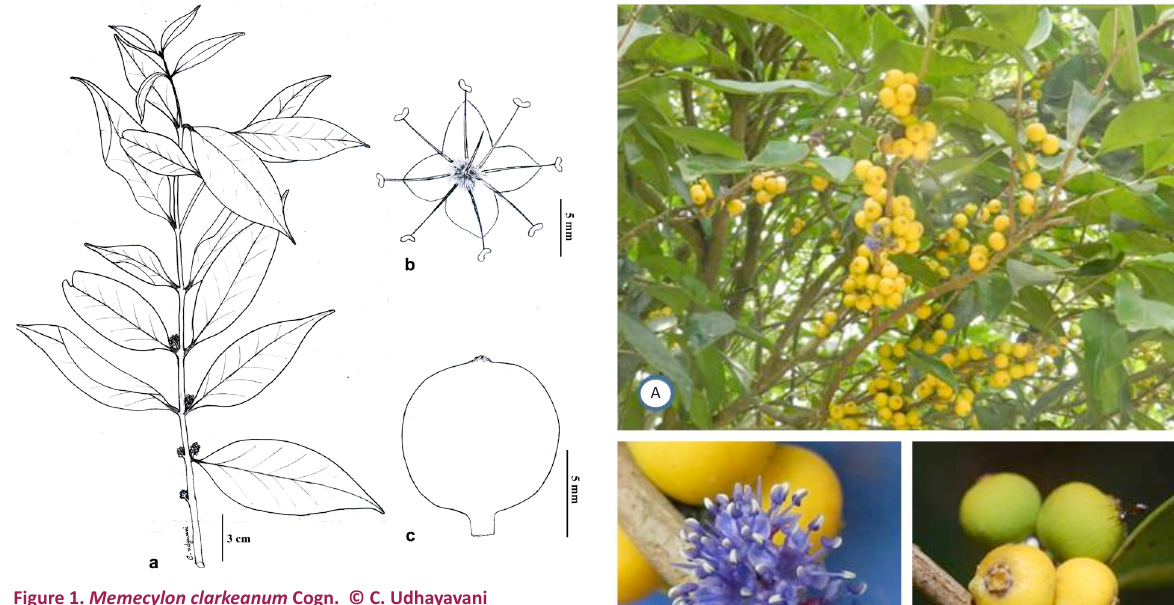
Figure 1. Memecylon clarkeanum Cogn. © C. Udhayavani a - habit, b - flower, c - fruit.